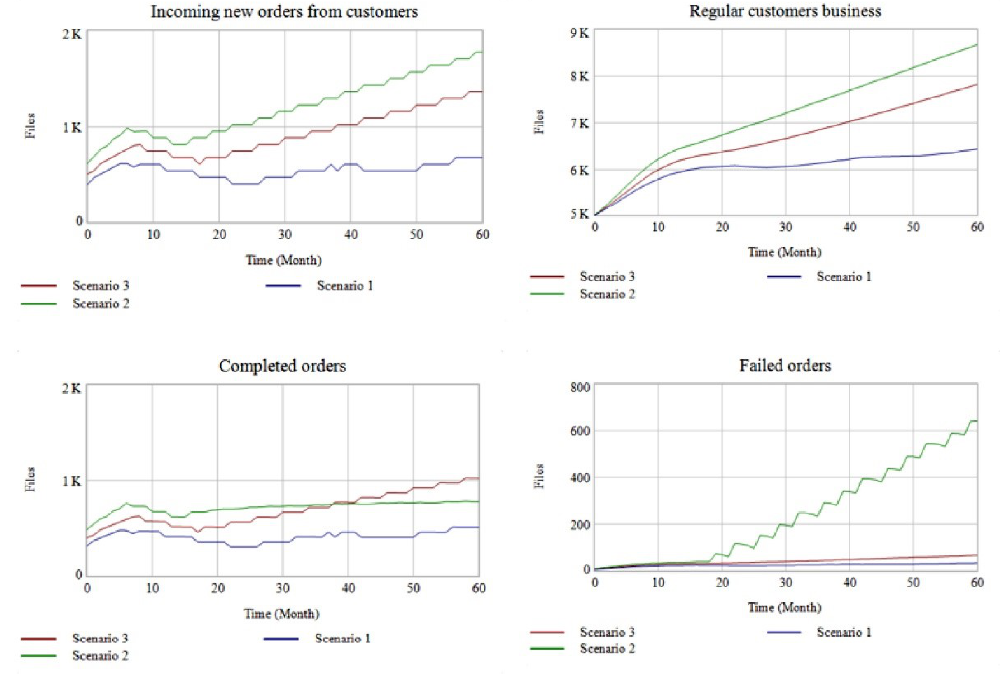
Fig. 10. Simulation of commercial activities (developed by the